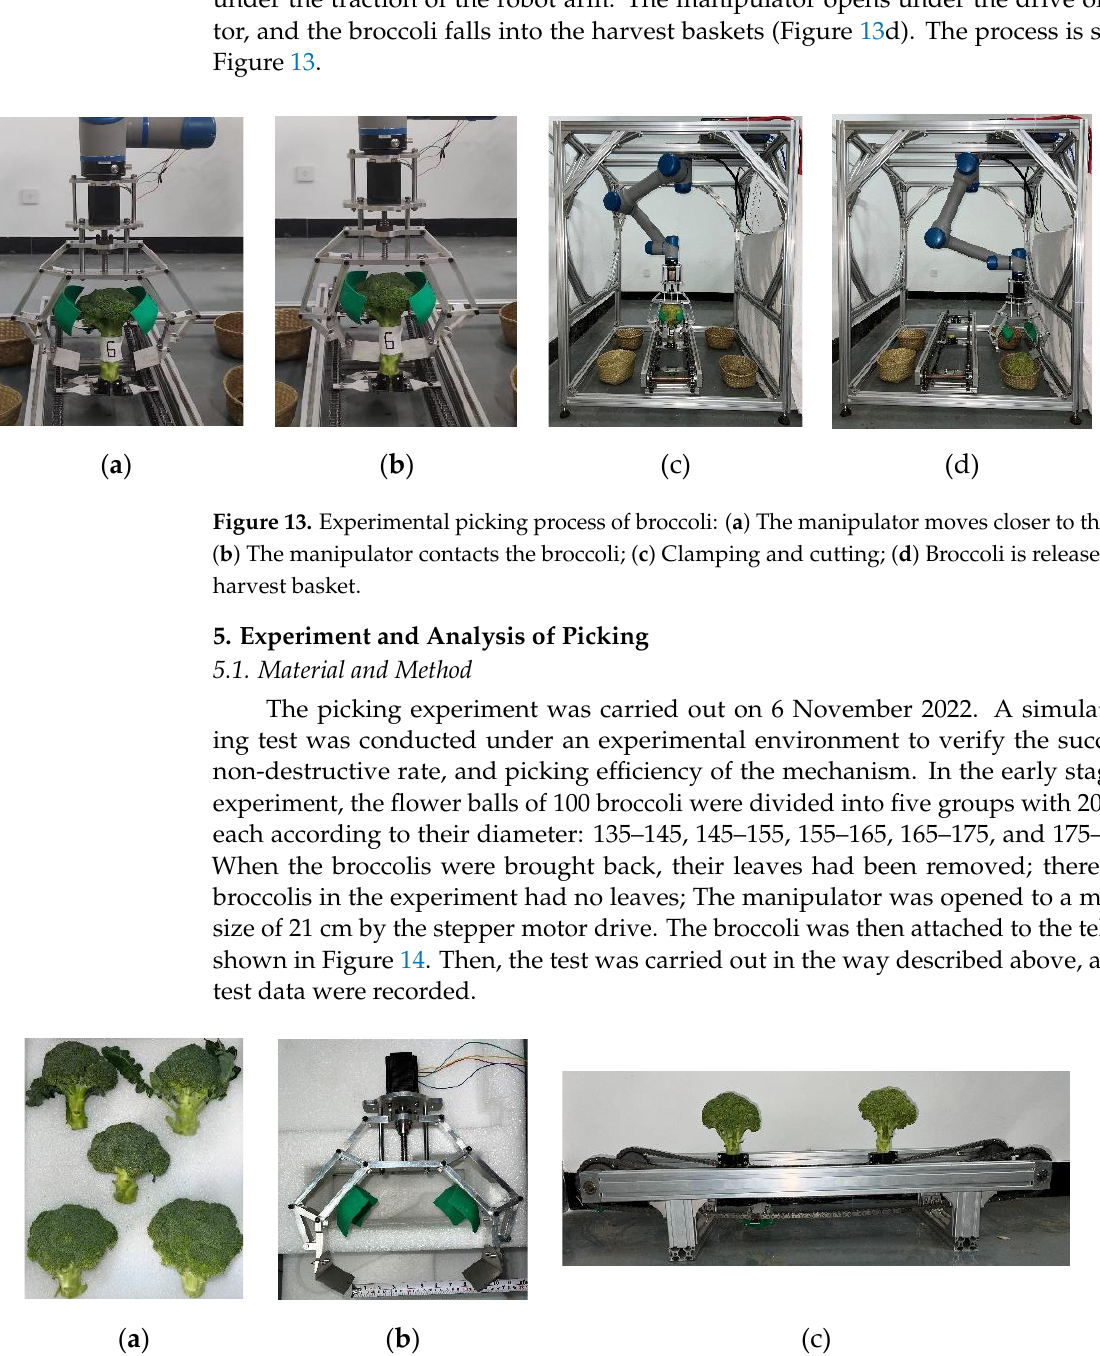
( b ) Figure 15. Successful picking factors: ( a ) Clamping damage was low, and plant height was greater than 12 cm; ( b ) The incision surface was flat and non-adhesive. Ten broccoli plants were selected from each of the five groups to determine the suc- cess rate of picking. The robot arm ran at 2.8 m/s, and the stepper motor ran at 60 r/min. As shown in Table 3, the success rate of broccoli picking can reach 84% on average. Table 3. The success rate of picking. Group